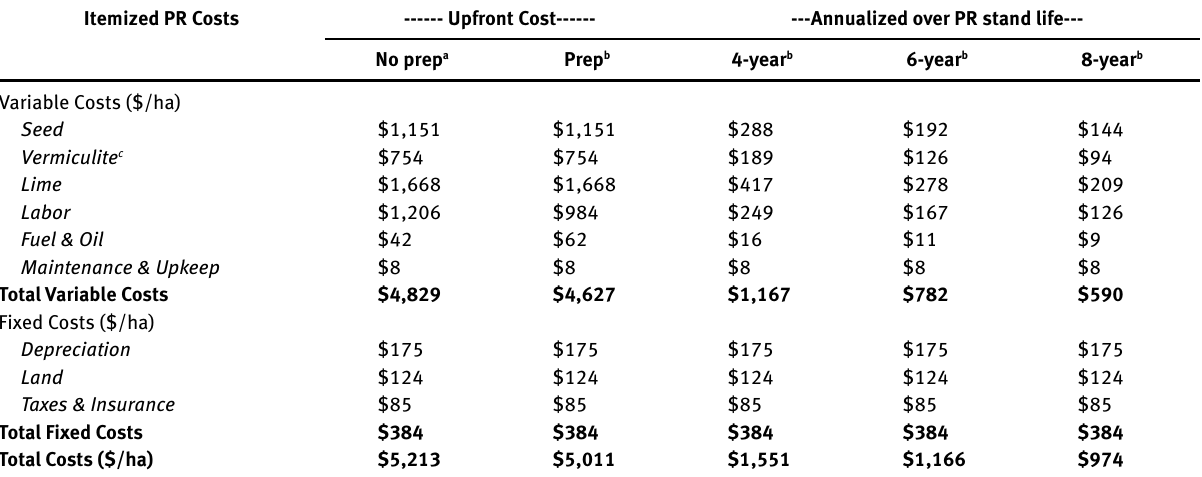
Table 2: Pollination reservoir (PR) costs. Costs are presented with and without a full-season of weed control. The full season of weed control scenario is annualized over 4, 6, and 8 years. Depreciation assumes 1% of farm budget Itemized PR